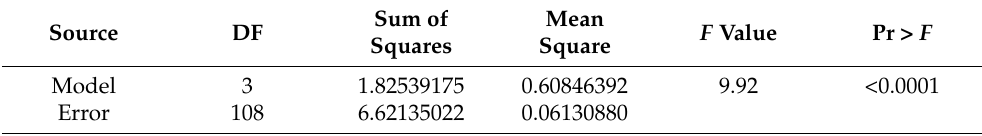
Table A3. Seed Mass.